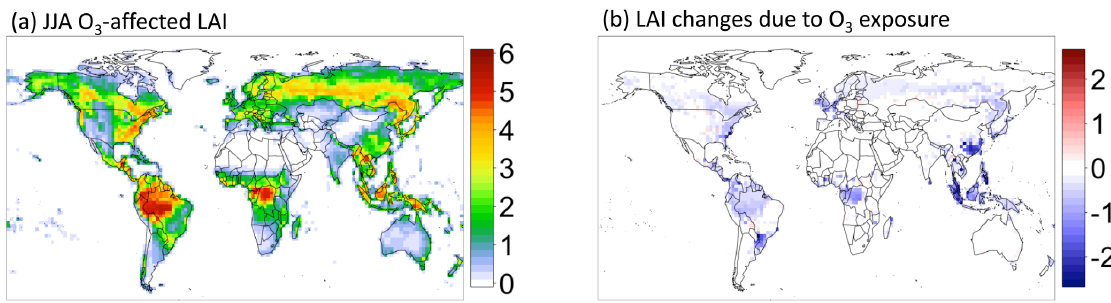
Figure 2. (a) Simulated leaf area index (LAI) affected by long-term ozone exposure in summer (JJA mean) in GEOS-Chem, and (b) differ- ences between ozone-affected LAI in (a) and intact potential LAI unaffected by ozone, i.e., (Affected_LAI –